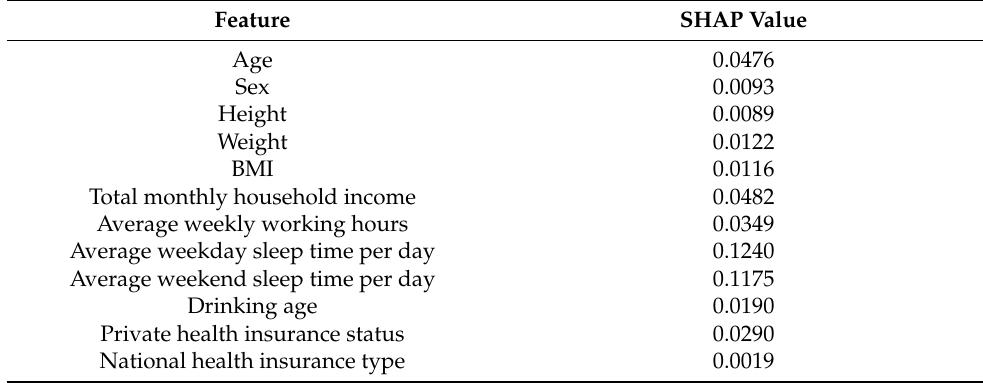
Table 10. SHAP values of hepatitis B risk association